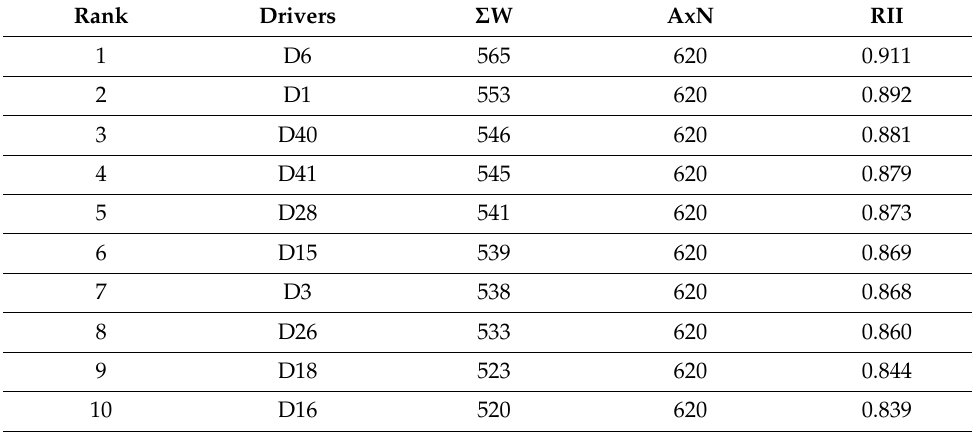
Table 4. Relative importance index of